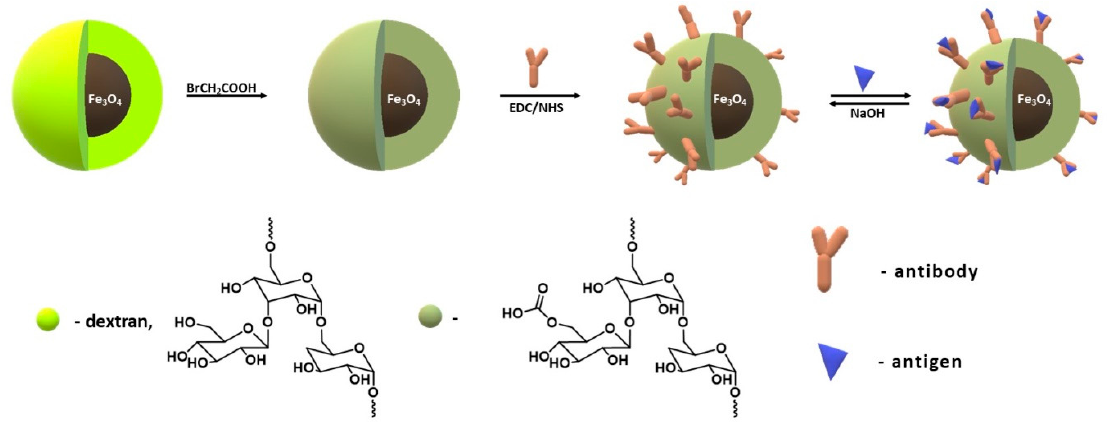
Figure 24. Synthesis of carboxymethylated dextran-coated magnetic nanoparticles (CMD-MNPs) covered with anti-bovine serum albumin (BSA) antibody and subsequent capture and release of BSA in sample solution.